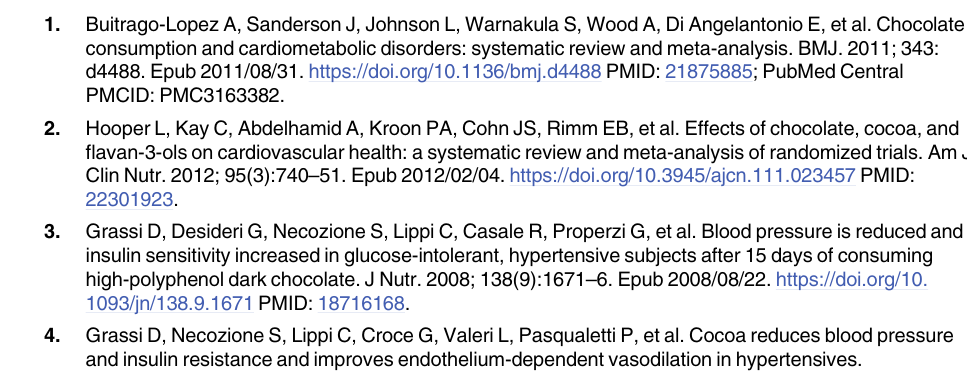
S1 Fig. Expression heat map of contributing genes within the upregulated gene sets involved in transcription/translation, tubulin folding and insulin synthesis and processing. Subjects were hierarchically clustered via the complete agglomeration method. Expression changes are indicated as individual signal-log-ratios (SLR) of T = 4 weeks versus T = 0 weeks. Downregulation or upregulation of gene expression is presented on a colour scale, ranging from green (downregulated, SLR (cid:20) -0.25) to red (upregulated, SLR (cid:21)